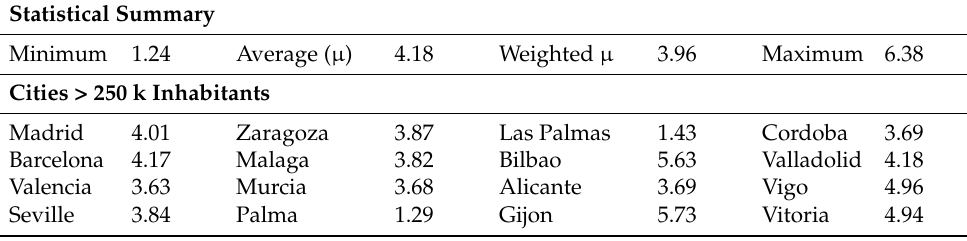
Figure A6. PV EB in years (S1 (consumption saving scenario) and S2 (surplus sale scenario)). Table A6. PV EB in years (S1 (consumption saving scenario) and S2 (surplus sale scenario)). Statistical